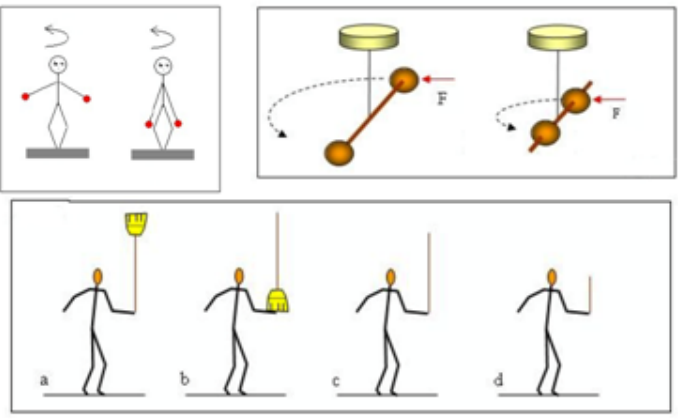
Figure 1. Physical situations shown to the